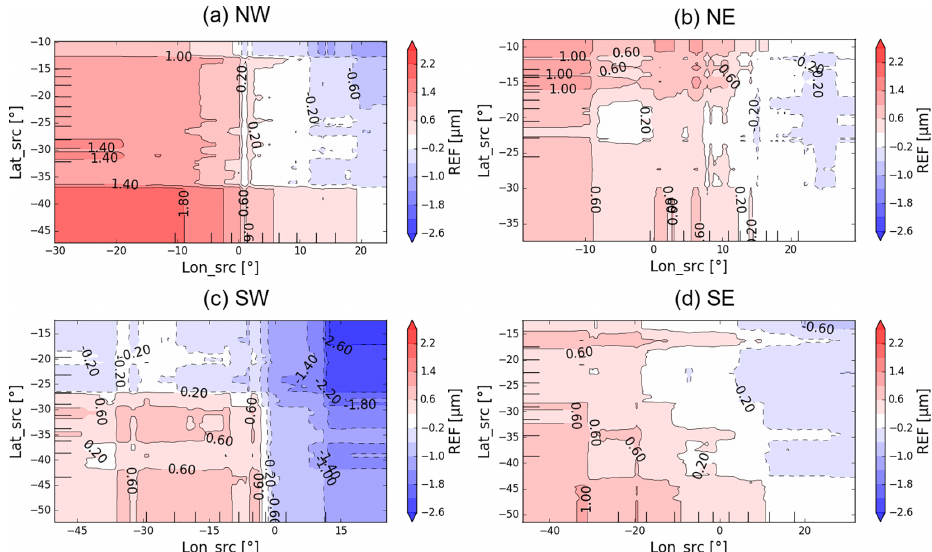
Figure 5. Two-variable partial dependence of REF on Lon_src and Lat_src in the in the four subregions (a) NW, (b) NE, (c) SW and (d) SE during JAS. Solid (dashed) contour lines indicate positive (negative) deviation of the predicted mean. The tick marks on the x axis and y axis indicate the deciles of the observations. For this illustration only one model run is selected at random as it represents all model runs with error ranges comparable to that of the one-variable partial dependencies.